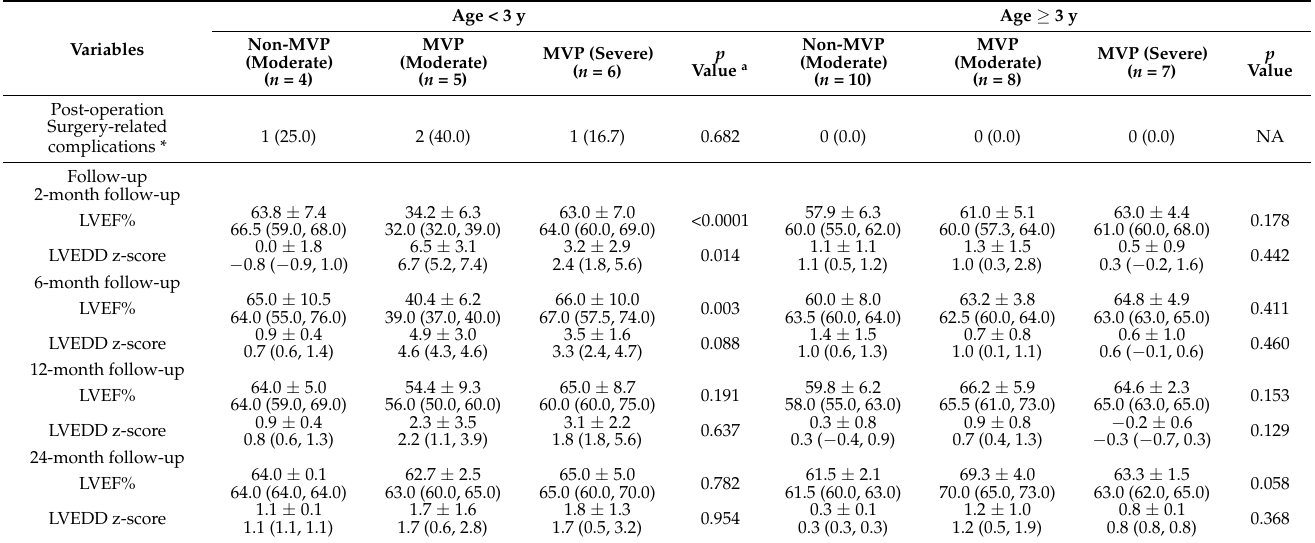
Table 3. Post-operative and follow-up information of ACAPA patients with and without mitral valve plasty grouped by